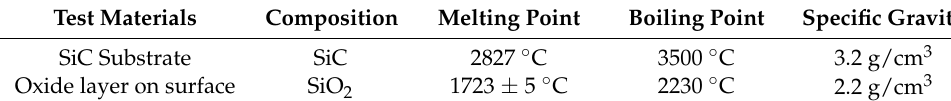
Table 1. Physical and chemical parameters of SiC and microparticle on surface.